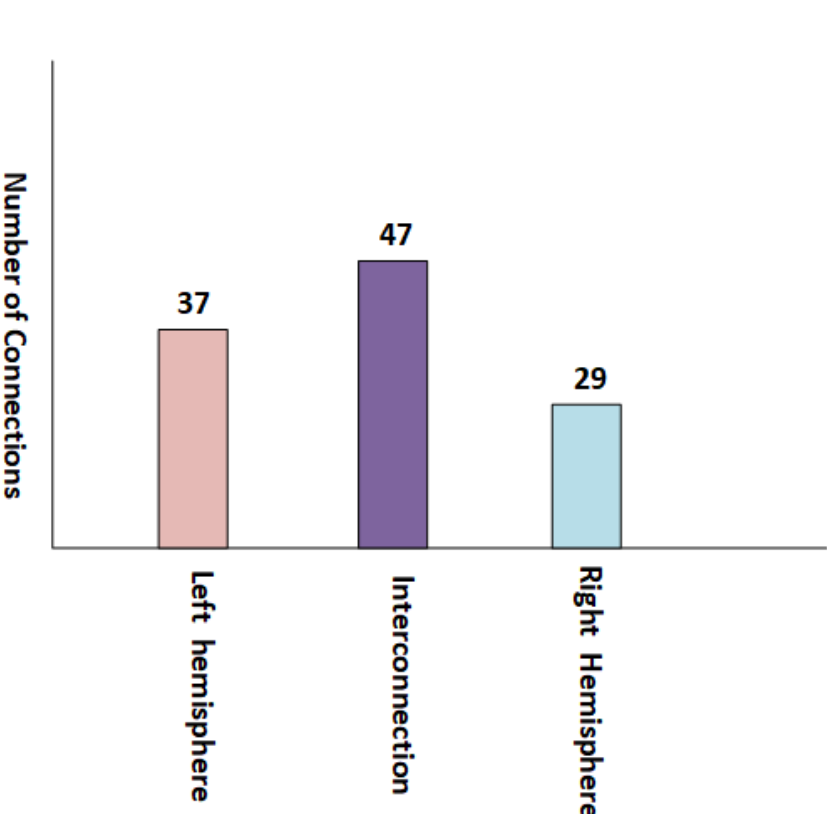
Figure 6. Brain’s nodes connection network counts between inter hemisphere and Intra hemisphere.